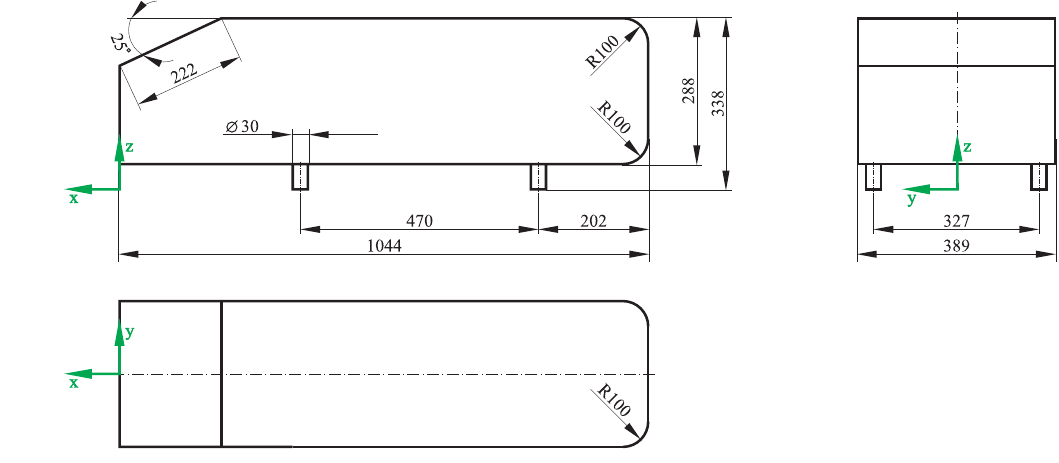
Figure 1. Dimensions of the Ahmed body used in this